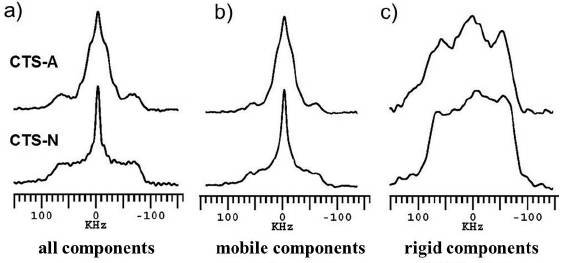
Figure 2. Dynamic-editing 2 H NMR spectra of CTS-A and CTS-N at room temperature: ( a ) solid-echo spectra recorded with a repetition time of 2 s; ( b ) saturation Recovery quadrupolar echo spectra with a saturation recovery delay τ 1 = 10 ms to selectively observe signals of mobile components; and ( c ) Torchia’s T 1 -filter spectra to selectively observe signals of rigid components.